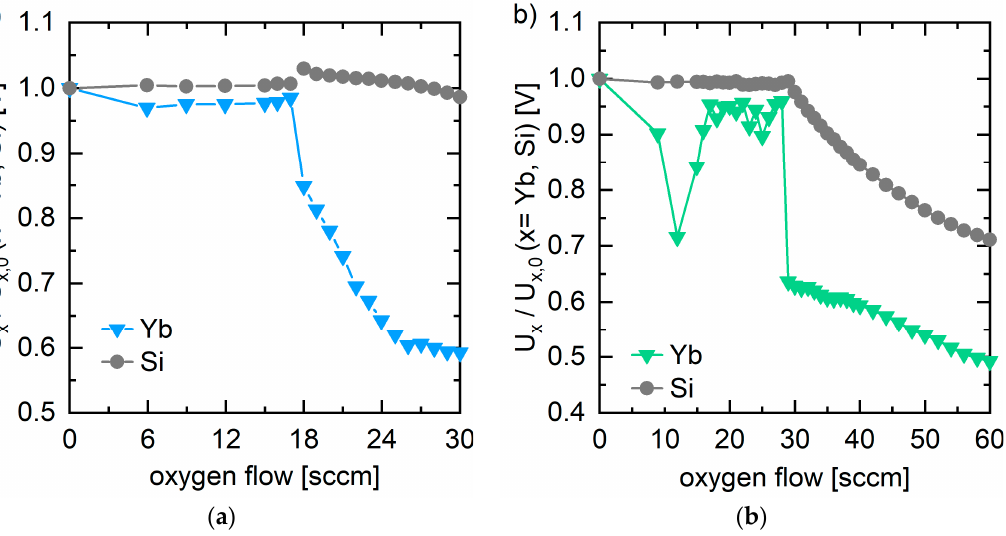
Figure 1. Discharge behaviour of the Yb and Si target plotted as ratio of the actual voltage to the initial voltage w/o reactive gas during the successive increase in oxygen flow at a total pressure of 4 × 10 − 3 mbar; ( a ) represents a power ratio that targets the YbDS composition; ( b ) represents a power ratio that targets the YbMS composition.